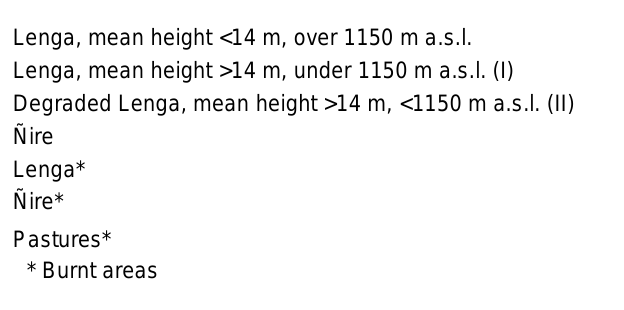
Current Distribution of Forest Ecosystems in the Project Area[11] Ecosystem Area in